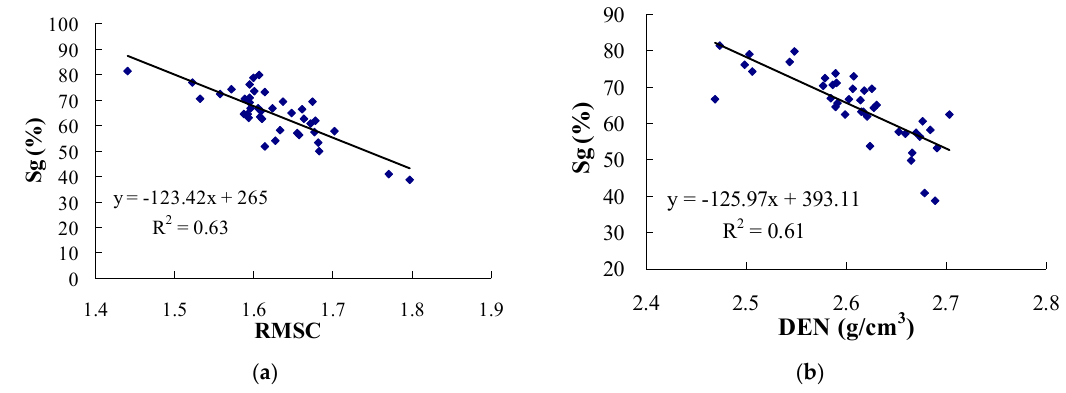
Figure 4. Relationship between the core gas saturation and logging parameters of the Longmaxi–Wufeng Formation shale in the Sichuan Basin: ( a ) correlation between core gas saturation and RMSC; ( b ) correlation between core gas saturation and DEN.